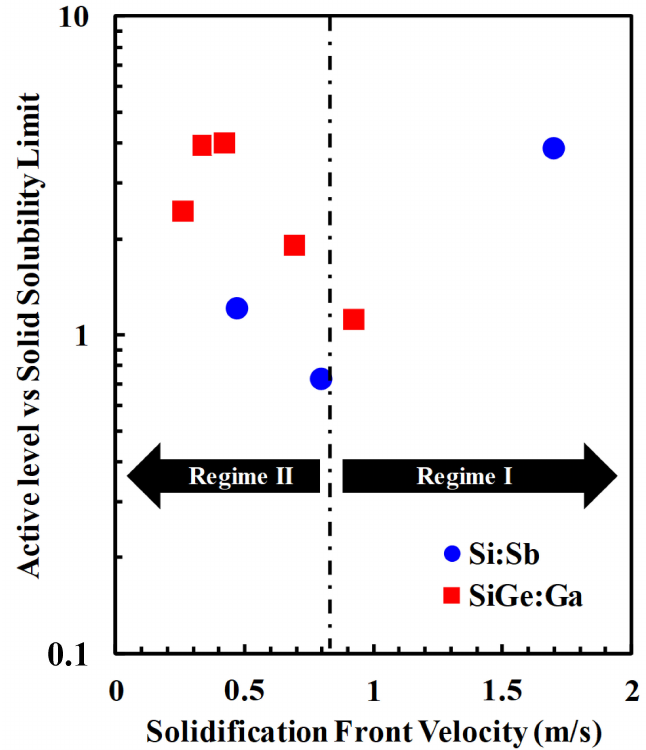
Figure 7. Plots of the degree of surpassing the solid solubility limit as a function of the simulated solidification front velocity ( V ) for the Sb-implanted Si and Ga-implanted SiGe samples. Reprinted with permission from Ref. [42]. 2020, AIP Publishing.